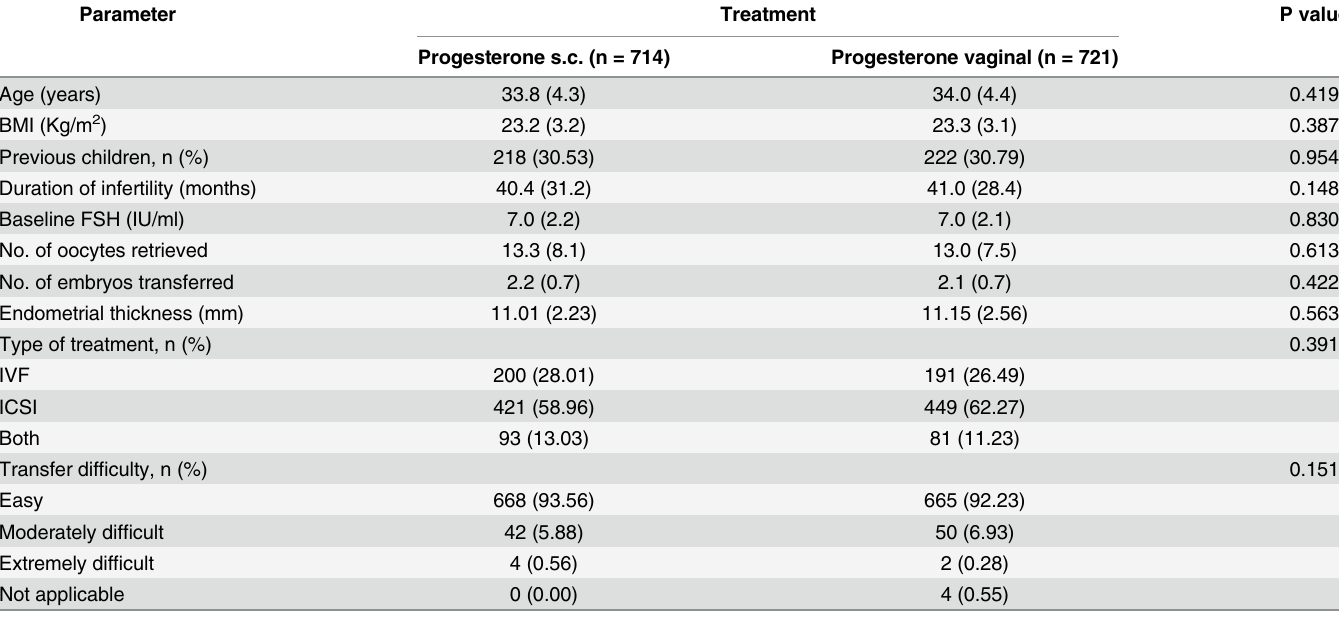
Table 1. Demographics and treatment characteristics in the total population of the two trials (values are mean ± standard deviation or numbers and